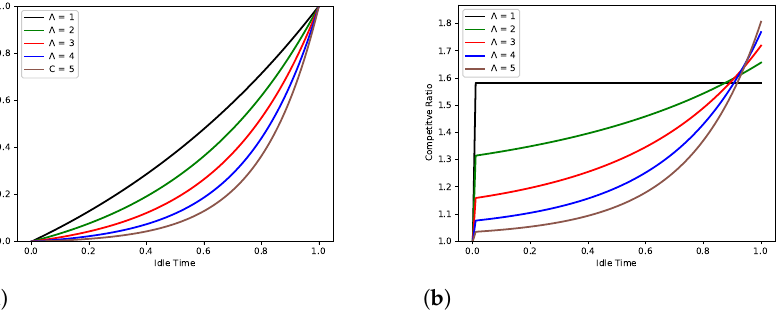
Figure 5. Exponential Strategy. ( a ) Transition rates for exponential strategies, linear system; ( b ) com- petitive ratios for exponential strategies, linear